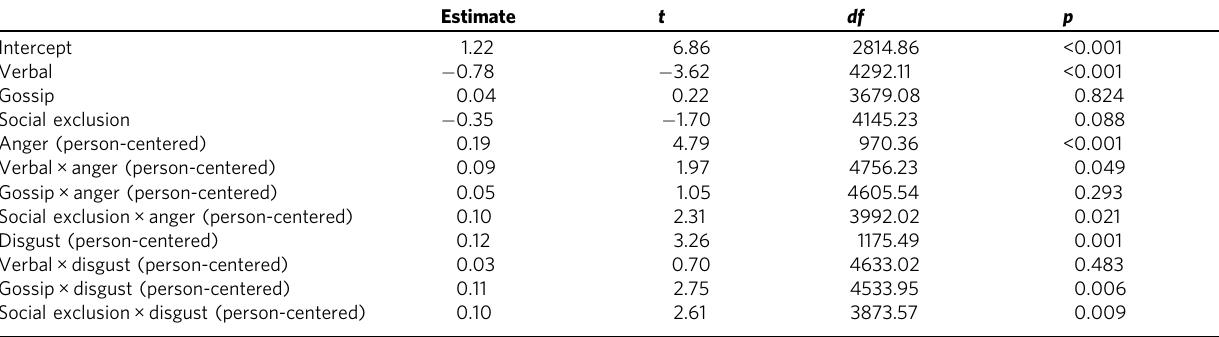
Table 4 Anger, disgust, and endorsement of punishment